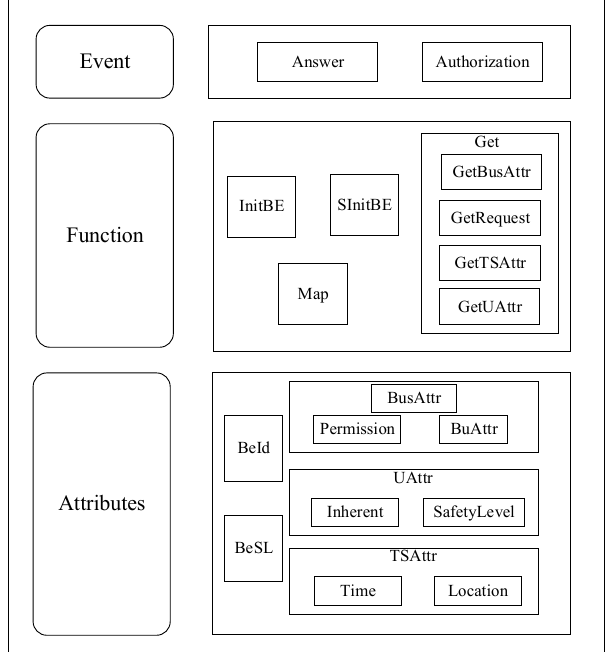
Figure 1. Structure of business entity.